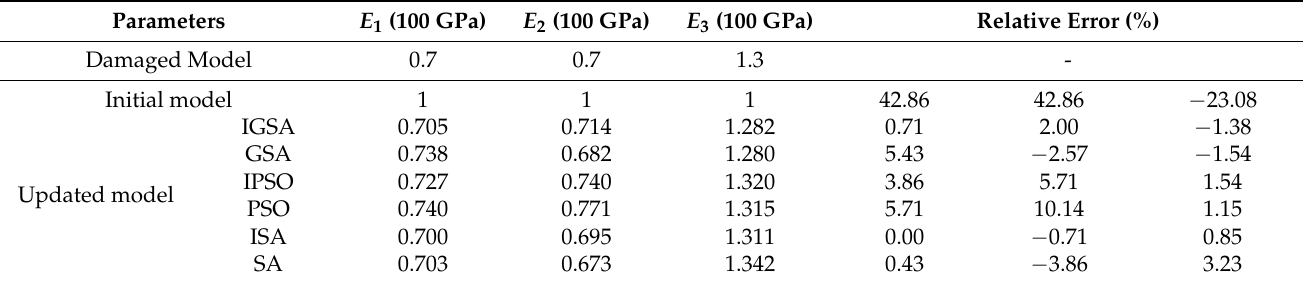
Table 2. The change of updating parameters in model updating.